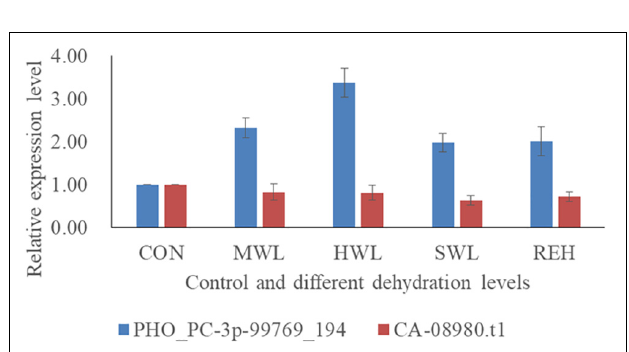
FIGURE 3 | Verification of the expression of PC-3p-99769_194 and its target CA